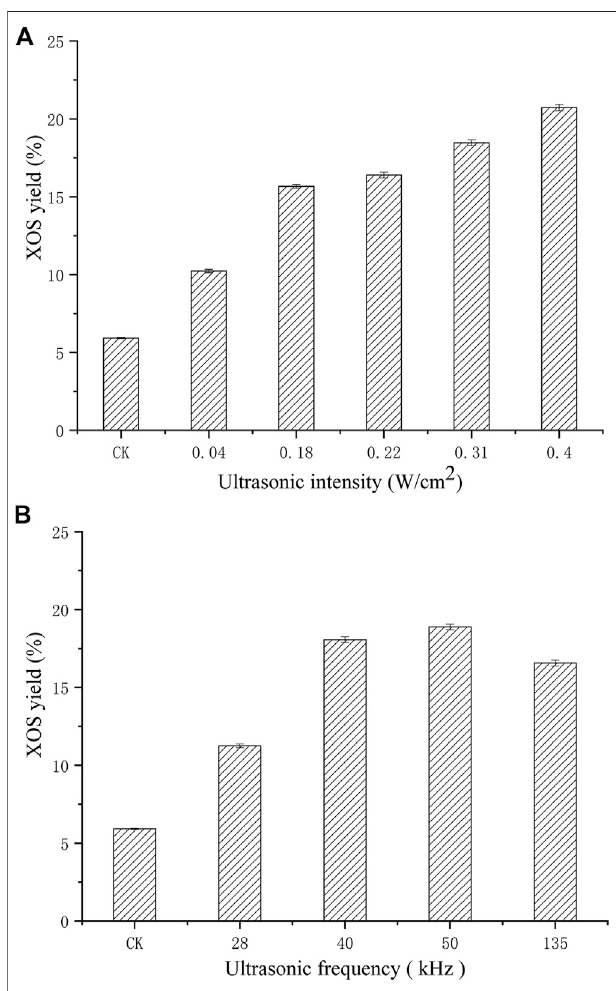
FIGURE 3 | Effects of pretreating XynB with different ultrasonic intensity (A) on xylanase hydrolysis at 50 kHz for 40 min, and ultrasonic frequency (B) on xylanase hydrolysis at 0.31 W/cm 2 for 40